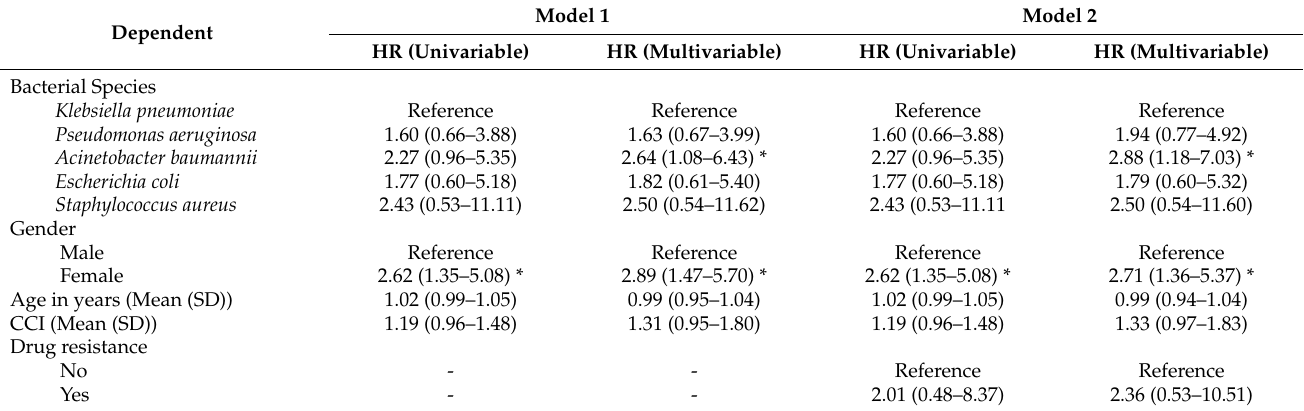
Table 2. Univariate and multivariate Cox regression analysis of the risk factors associated with